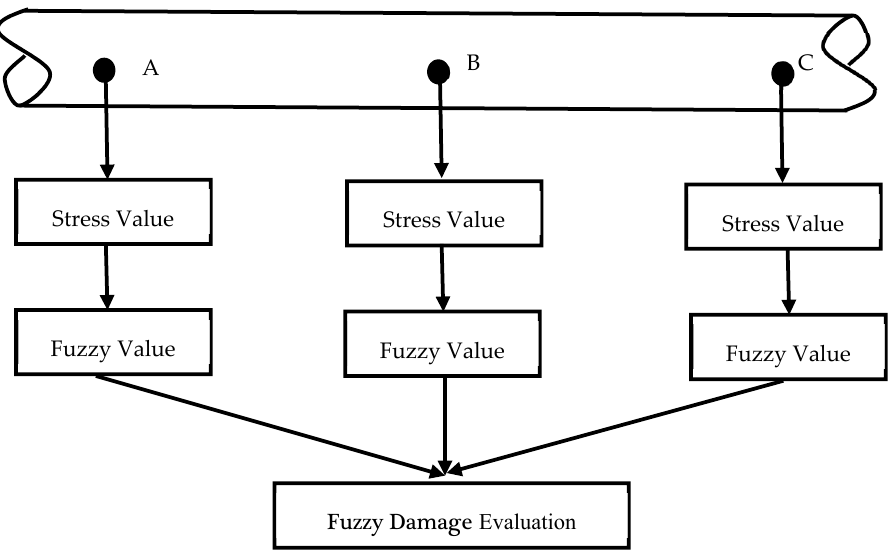
Figure 10. Estimation of logic for damage fuzzy evaluation in the pipeline.